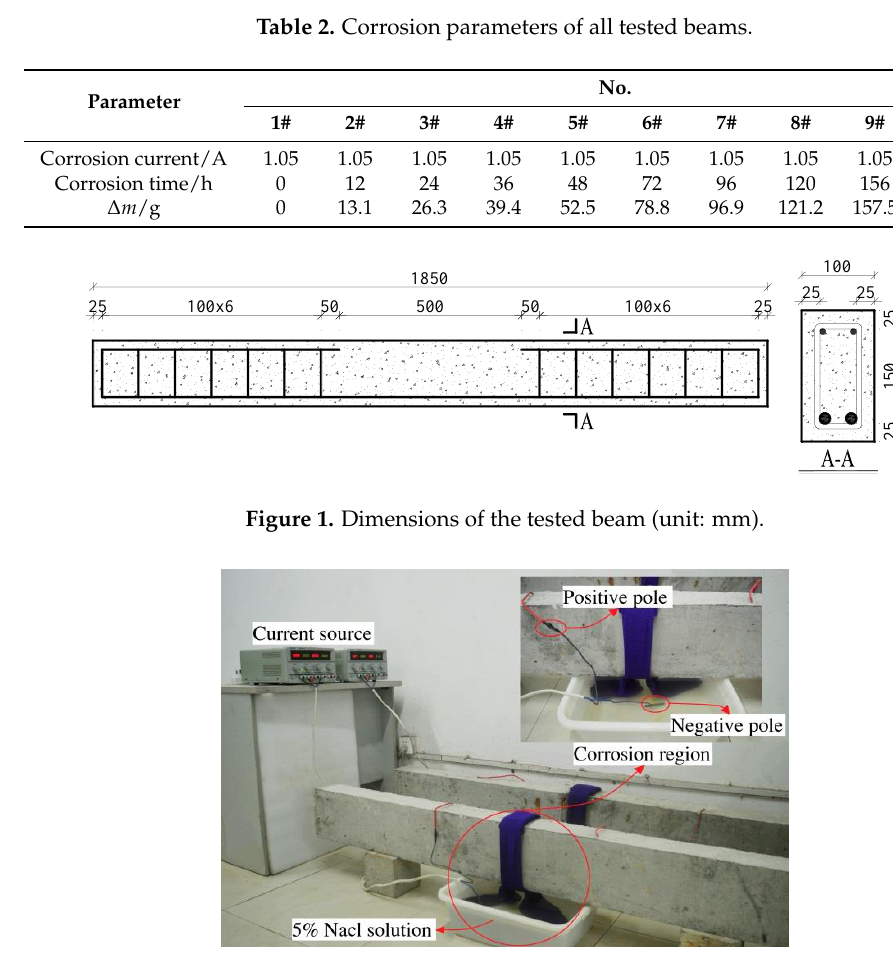
Figure 2. Layout of the corrosion device.